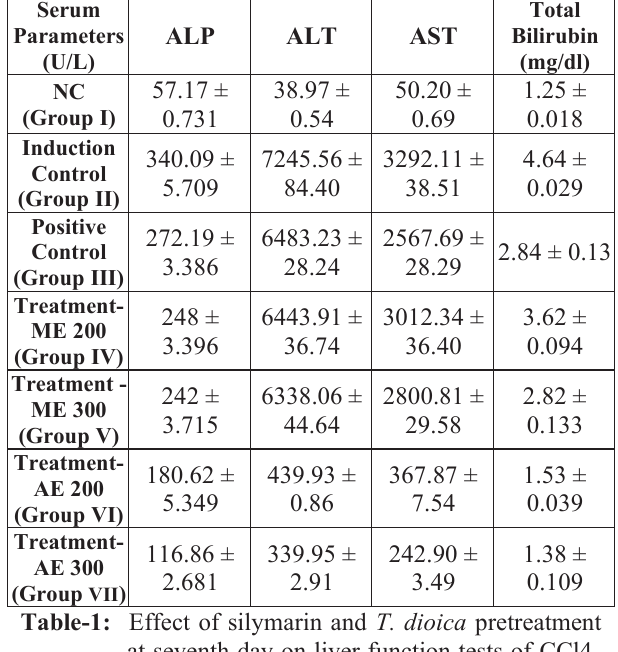
Table-1: Effect of silymarin and T. dioica pretreatment